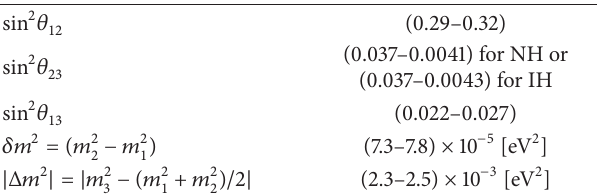
Table 1: Summary table of ] properties from [12]. We use the convention where 𝑚 2 > 𝑚 1 (therefore 𝛿𝑚 2 > 0 by construction) and 𝑚 3 is the most split state. We report here the 1𝜎 range for each parameter (note that in the case of 𝜃 23 we report a different range for normal (NH) or inverted hierarchy